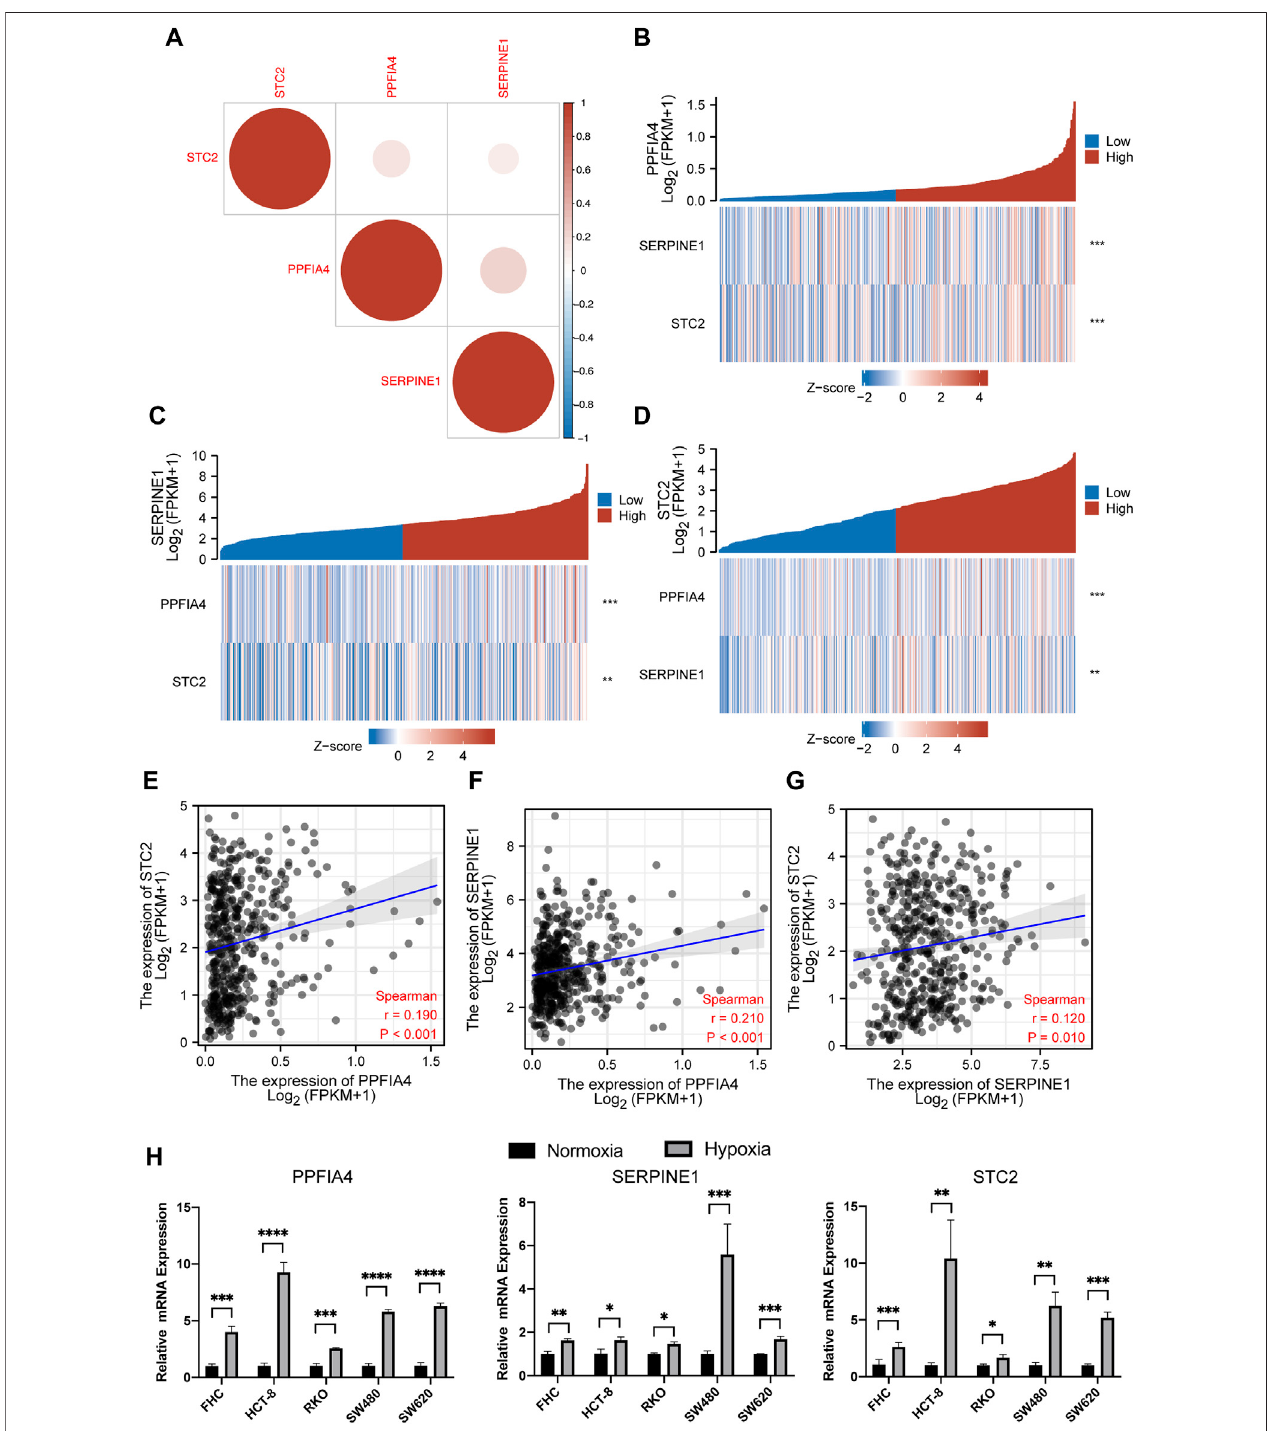
FIGURE 9 | The correlation among the expression of three hub genes. (A) The plot illustrated that the expression of all three genes was positively related. (B,C,D) Three expression correlation plots visualized that with increasing expression of one hub gene, the expression of two other hub genes statistically increased. (E,F,G) The plots of the Pearson correlation coef fi cient showed the correlation between PPFIA4 and SERPINE1 was the strongest, followed by the correlation of PPFIA4 and STC2 andthecorrelationbetweenSERPINE1andSTC2.Thisresultwasfollowingthepreviousresultshownin (A) .TheresultsofqPCR (H) showedthatthreehubgenes were highly expressed under hypoxic cultivation in different colon cell lines, including colon epithelial cell line (FHC) and CRC cell lines (HCT-8, RKO, SW480, and SW620). * represents p < 0.05, ** represents p < 0.01, *** represents p < 0.001, **** represents p < 0.0001.